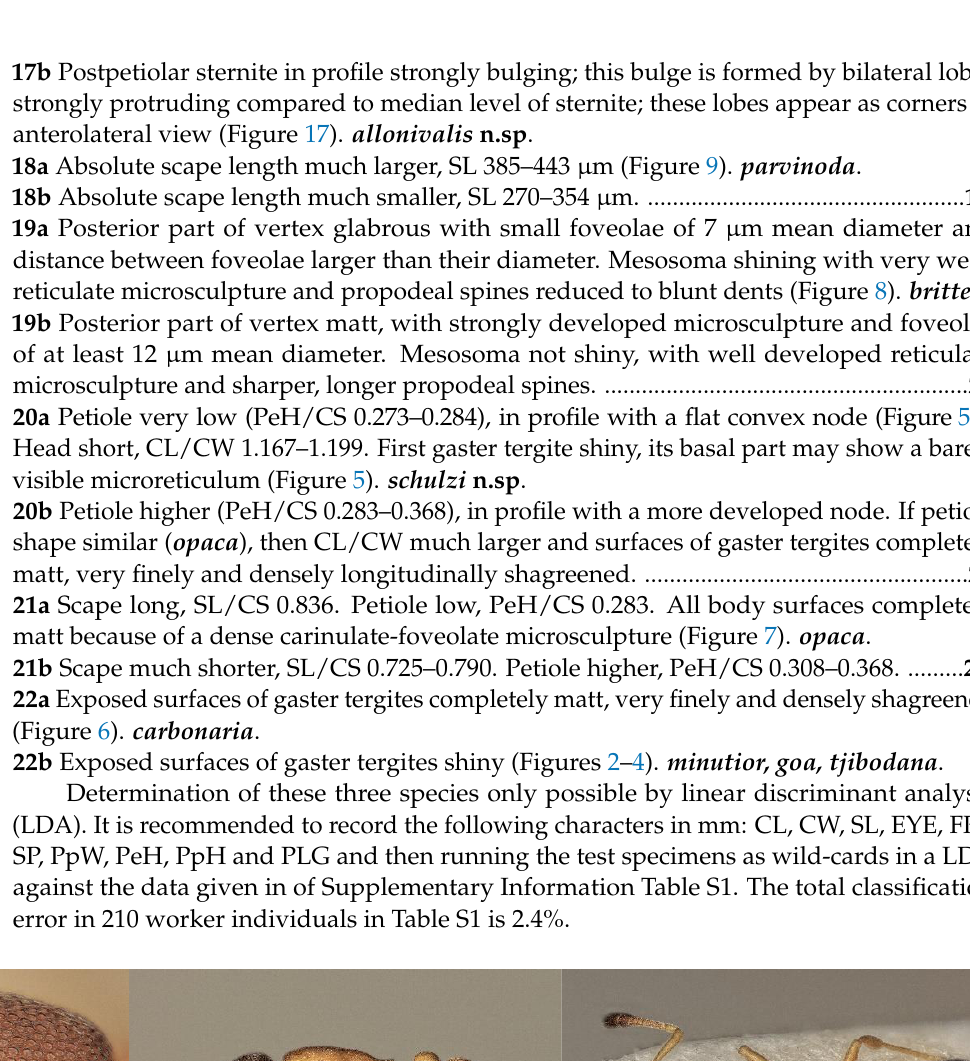
Figure 3. Cardiocondyla goa, holotype: head in dorsal view ( A ), lateral view ( B ), dorsal view ( C ).